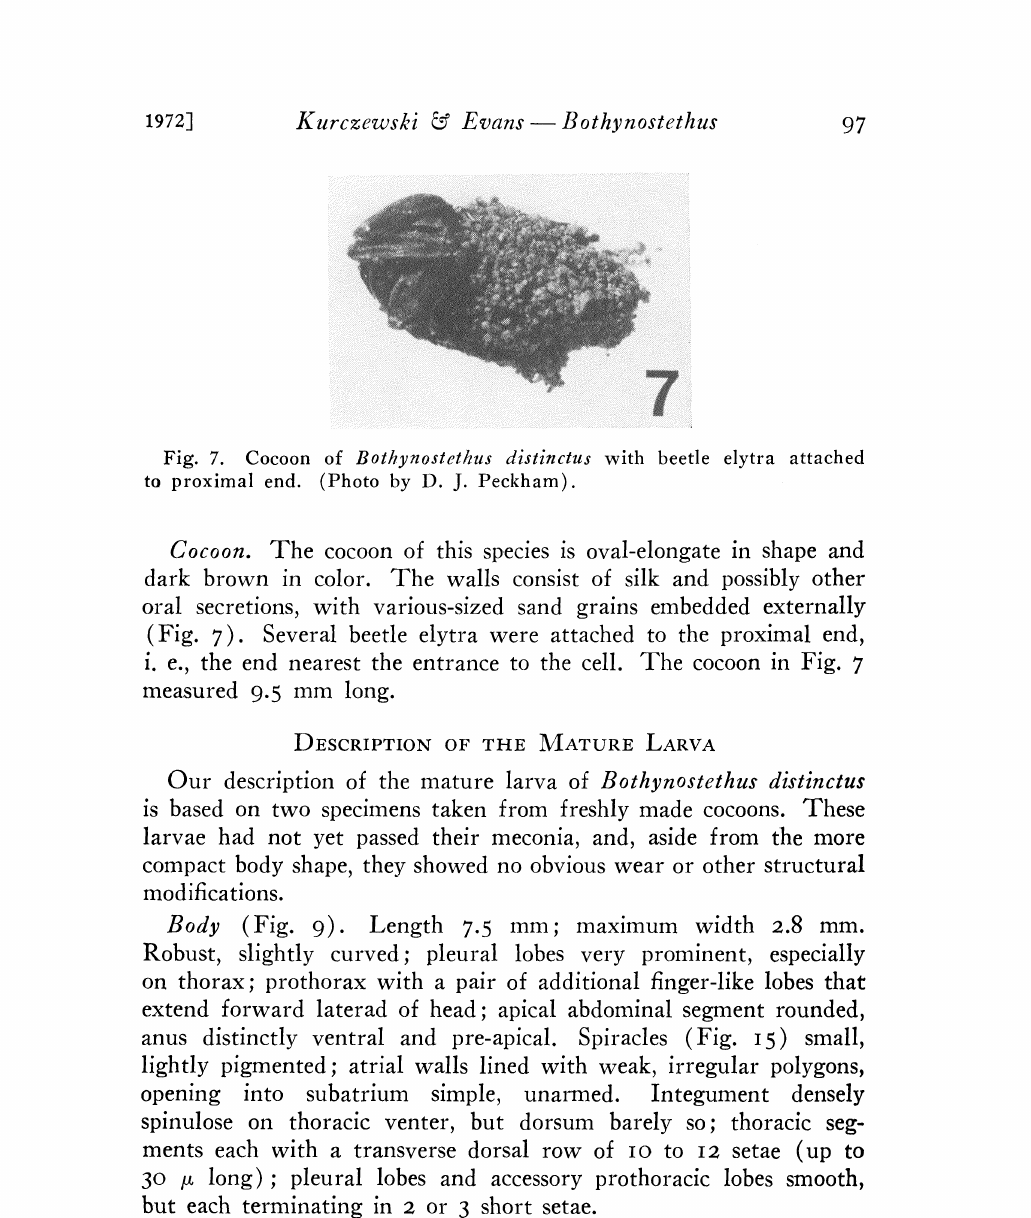
Fig. 7. Cocoon of Bothynostethus distinctus with beetle elytra attached to proximal end. (Photo by D. J.